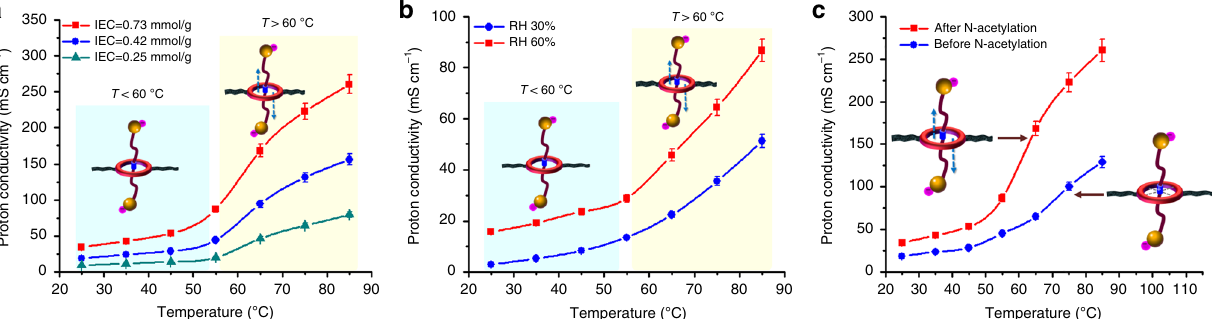
Fig. 4 Proton conductivity of polyrotaxane membranes. a Proton conductivity of polyrotaxane membranes with varied IEC values as a function of temperature. b Proton conductivity of the polyrotaxane membrane (IEC = 0.73 mmol g − 1 ) as a function of temperature at 30% RH and 60% RH. c Proton conductivity of the polyrotaxane membrane (IEC = 0.73 mmol g − 1 ) before and after N-acetylation as a function of temperature. The error bars represent the s.d. from three